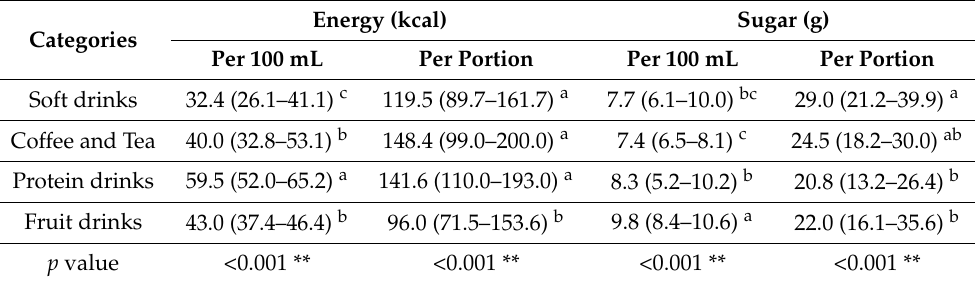
Figure 3. Distribution of SSBs classified as high calorie or high sugar according to Chilean criteria and SSBs with >25 g sugar per portion, grouped by category. Table 5. Description of energy and sugar content among different SSBs 1,2 .